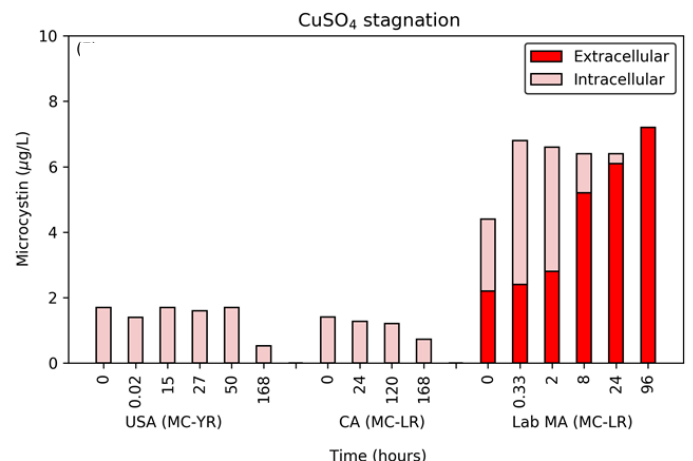
Figure 3. Release of intracellular toxin during extended exposure (96 or 168 hours) to copper sulfate for the three cyanobacterial suspensions.